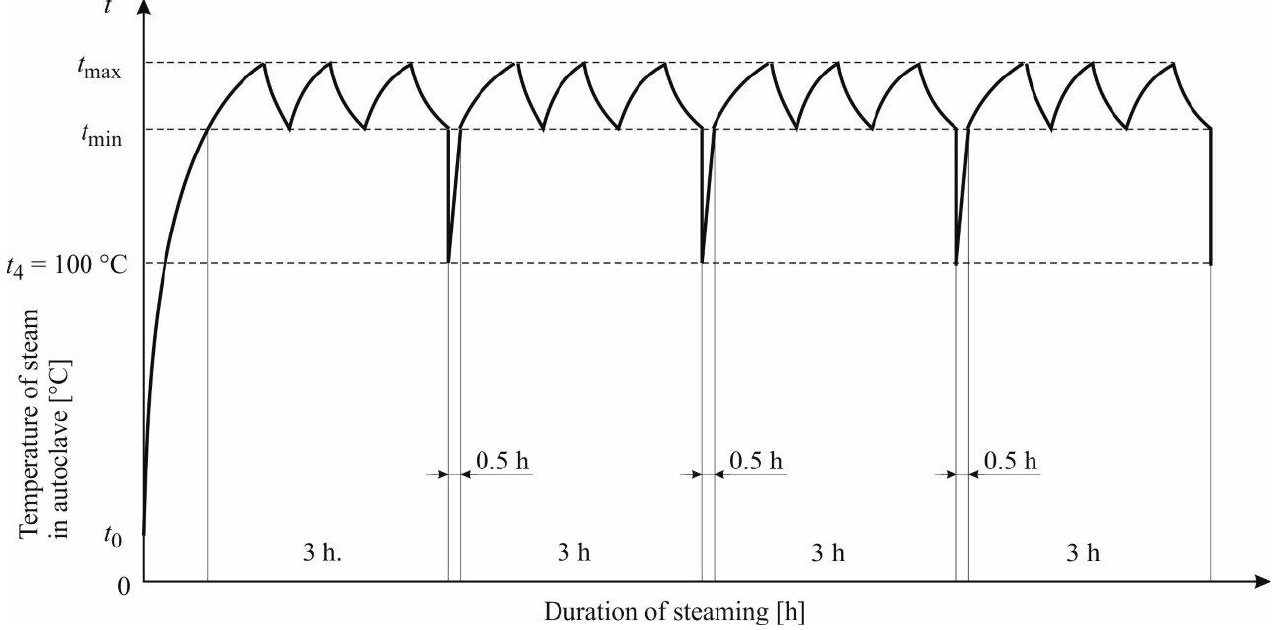
Figure 1. Diagram color modification of alder wood with saturated water steam.